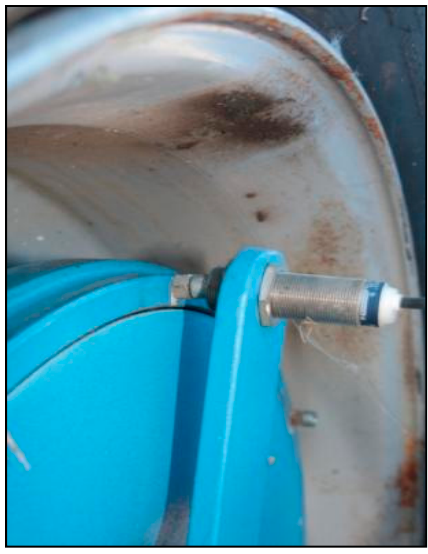
Figure 4. Sensor mounted on the wheel.